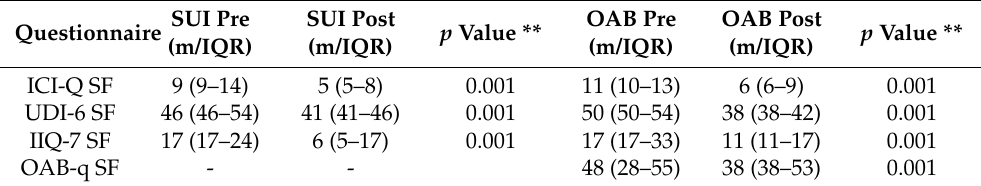
Table 4. Changes in patients reported outcomes at 2 months follow-up.